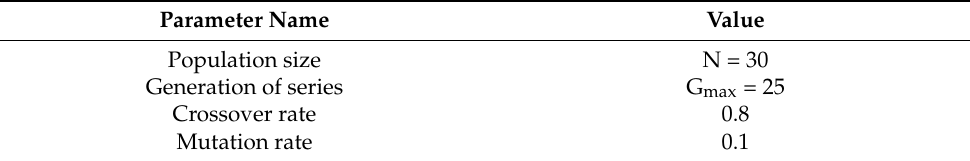
Table 4. Parameter setting of the genetic algorithm.